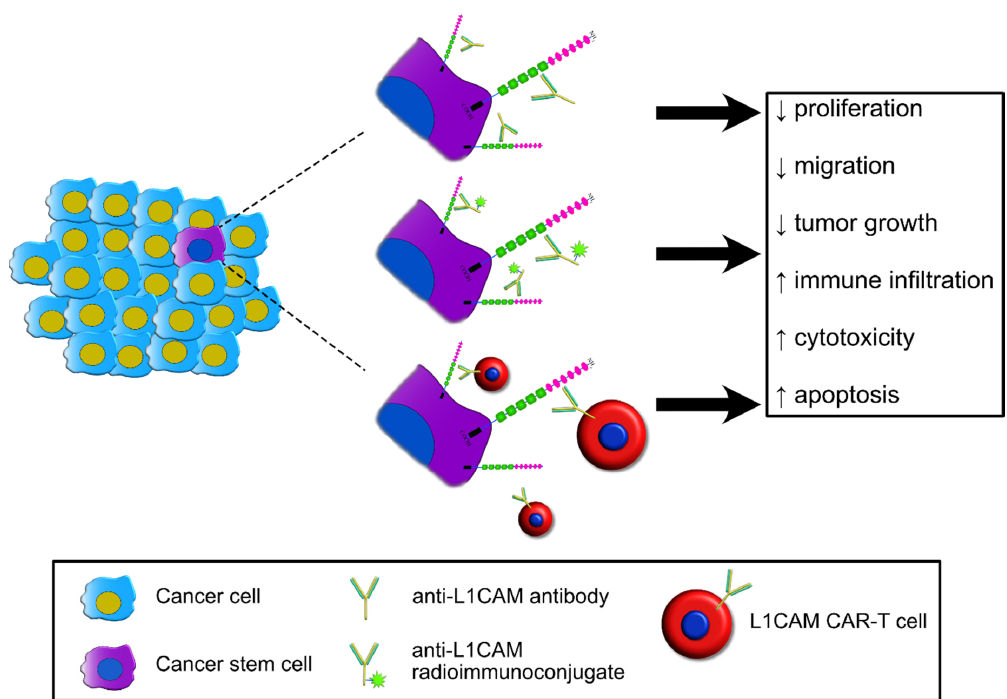
Figure 4. L1CAM is a viable therapeutic target in cancer. Three strategies for targeting L1CAM in cancer cells are depicted. Such strategies are based on neutralizing